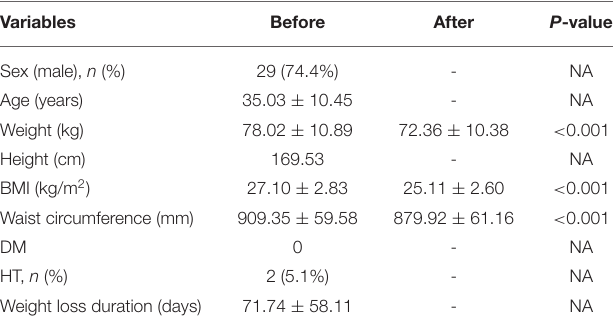
TABLE 1 | Baseline characteristics of the 39 living